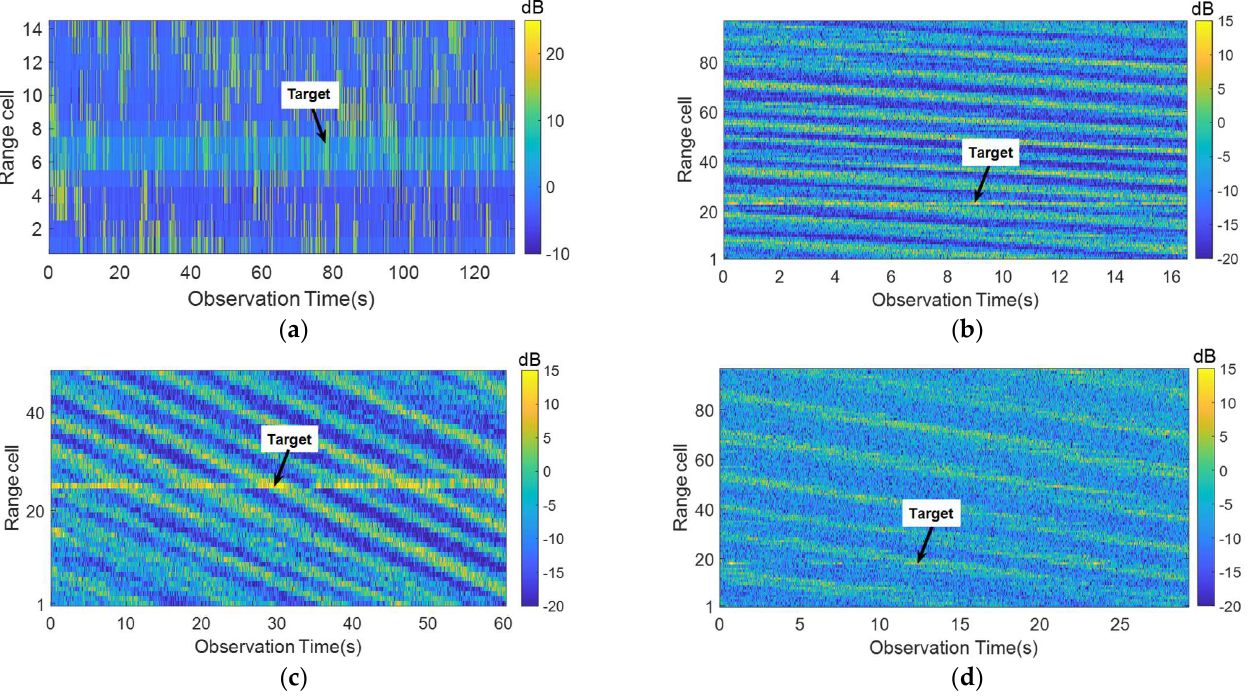
Figure 1. Radar echo intensity images of different observed targets. ( a – d ) show the intensity images of data #IPIX_01, #CSIR_01, #CSIR_02, and #CSIR_03, respectively. The arrow points to the target motion trajectory. ( a ) The floating ball; ( b ) The floating fishing boat; ( c ) The floating fishing boat; ( d ) The floating RIB.